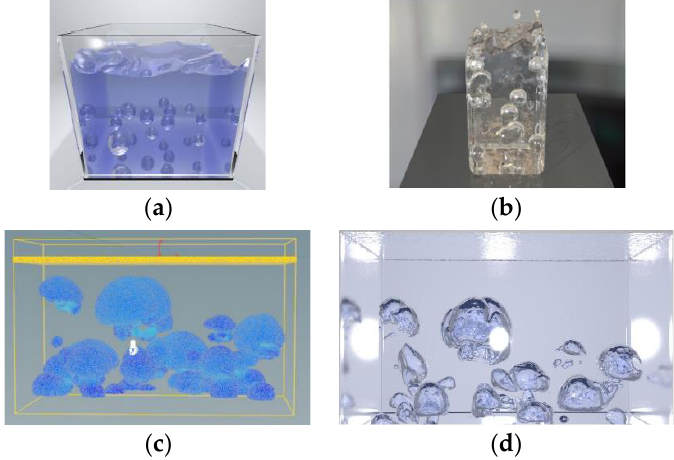
Figure 11. Comparison of generation effects of large-scale bubbles. ( a ) Reference [11], ( b ) Reference [29], ( c ) This paper (in particle form), ( d ) This paper (after rendering).